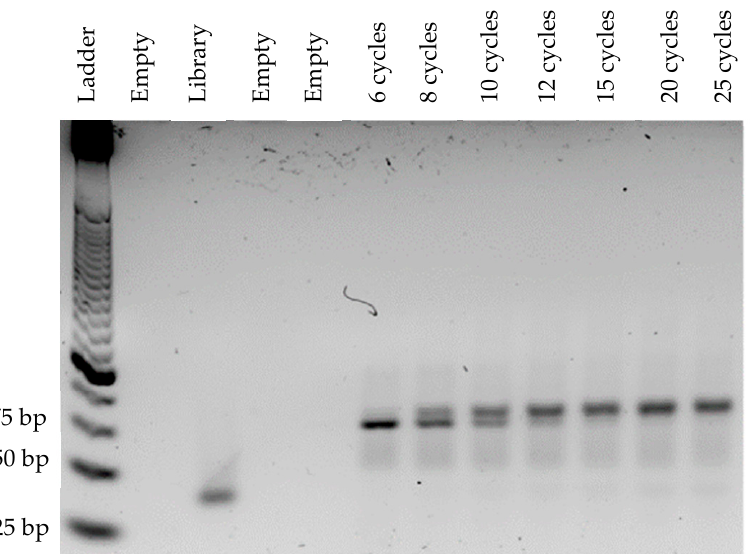
ssDNA, respectively. With an excess number of beads relative to dsDNA (50 mg for 2 µ g of dsDNA), the capture of the PCR product was very efficient since no band corresponding to Figure 1. ( a ): Agarose gel electrophoresis (4% agarose, 90 V, 2 h in TAE 1 X GelRed ® ) of the PCR the PCR product could be detected after the capture and washing steps (data not shown). products of the aptamer library with 20 cycles of amplification and annealing temperatures ranging For all NaOH concentrations, the predominantly eluted DNA was ssDNA. However, for from 50 °C to 70 °C. The legends above the gel correspond to the tested annealing temperatures. ( b ): NaOH concentrations above 200 mM, dsDNA contamination was observed (Figure 4b), Representation of the band intensities (ImageJ) as a function of the tested annealing temperature. indicating the dissociation of the biotin-streptavidin bond. Comparison of the intensity of Band intensities represent the amount of dsDNA produced. the bands with ImageJ software showed that 150 mM of NaOH allowed for a better ssDNA recovery compared to 20 or 75 mM NaOH (Figure 4b). This concentration was therefore considered optimal and was used for the following experiments.